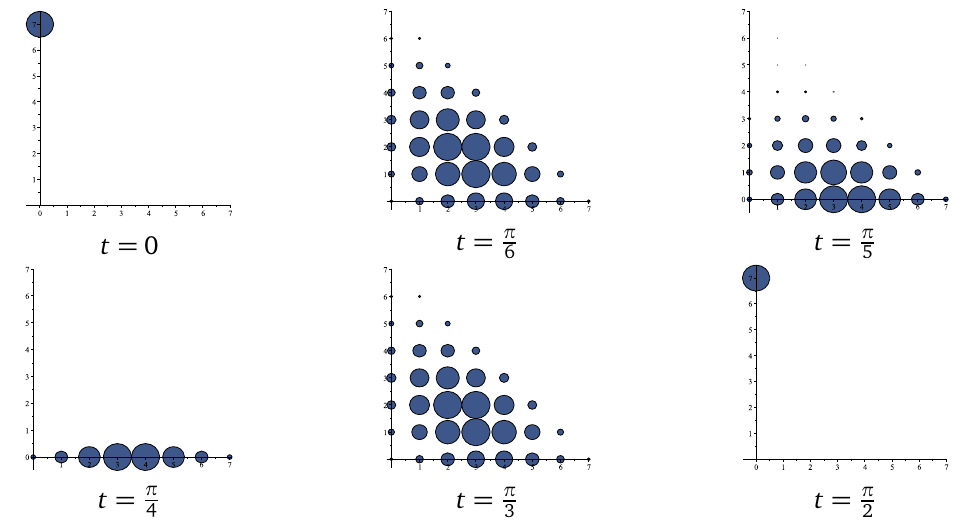
(cid:112) ( t ) | for + A = 7. The 2 A ( ( 0,1 ) when N i , j 1,0 ) ( t ) | at the given lattice point ( i , j ) . FR i , j ) π 4